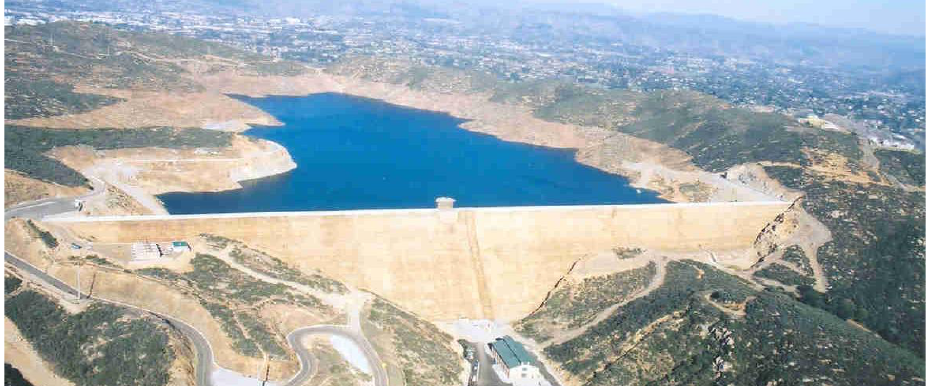
Figure 1. Roller - compacted concrete dam Olivenhain, USA, 2004.